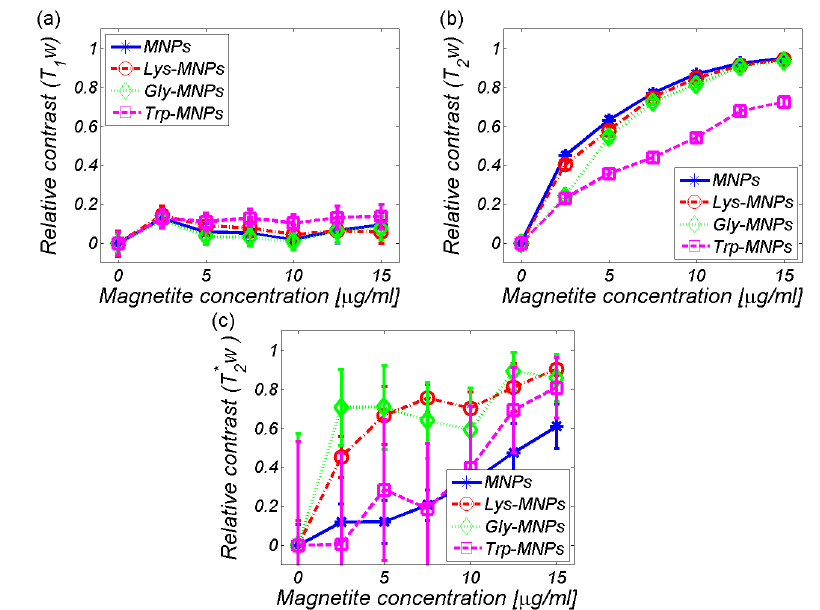
Figure 8. Relative contrast (RC) of the AA–MNP complexes depending on the IONPs / Fe concentration. ( a ) T 1 -weighted, ( b ) T 2 -weighted, ( c ) T 2* -weighted.